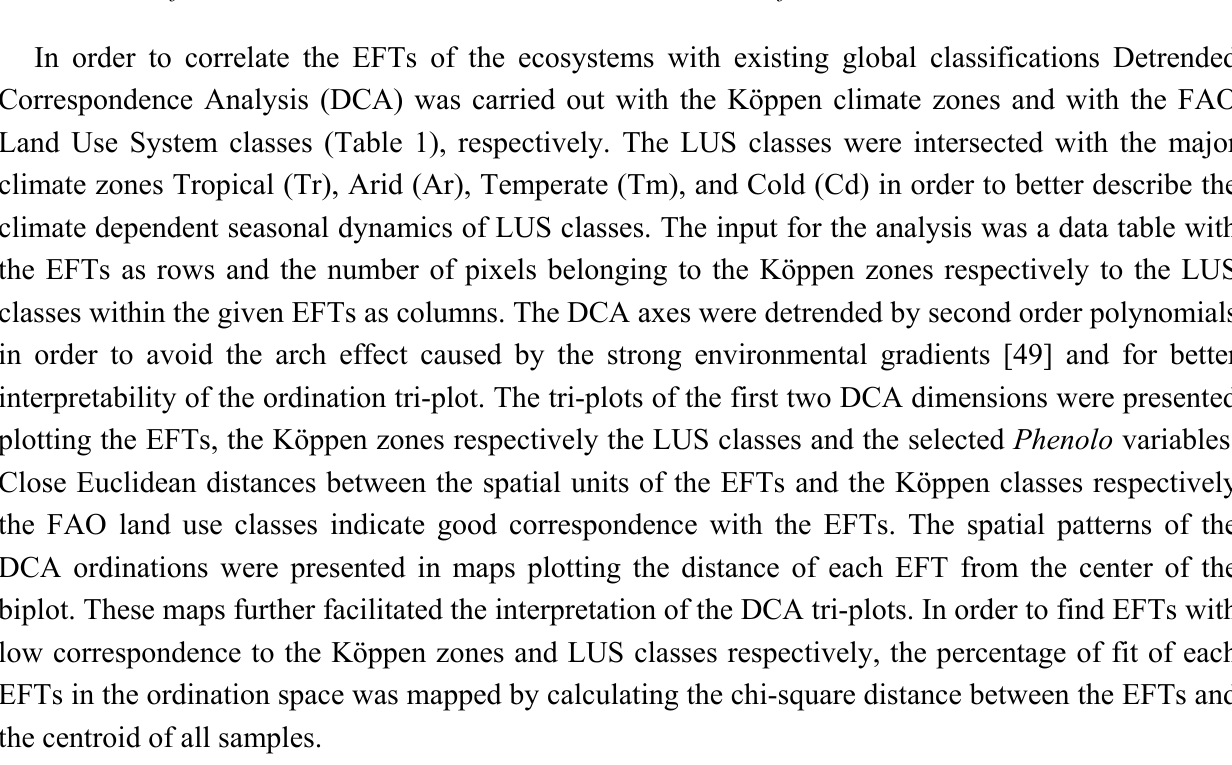
Table 1. Köppen climatic zones and FAO Land Use Systems classes used in the present study. LUS